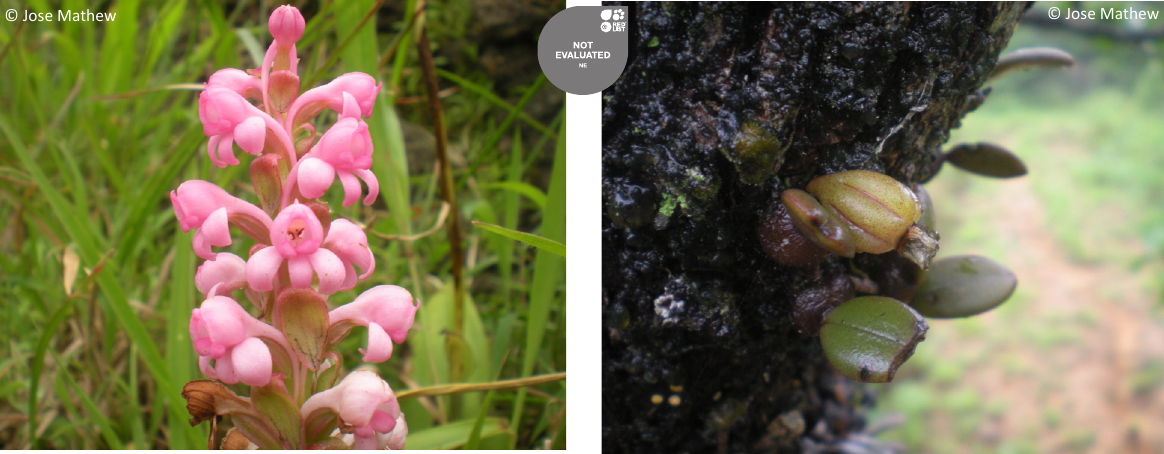
Image 5. Satyrium nepalense D. Don